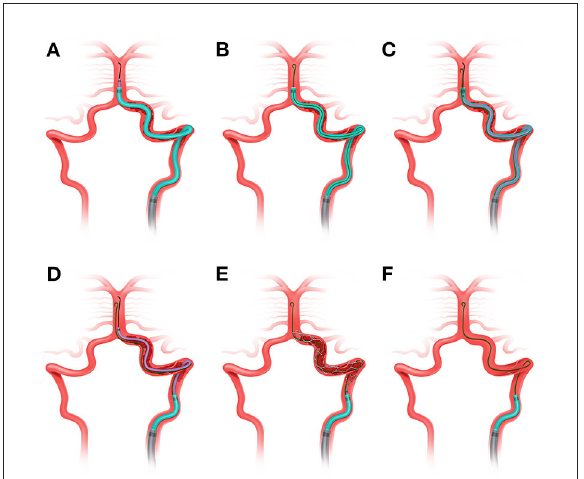
FIGURE1 Illustration of “standby microwire technique”. (A) The guiding catheter (gray) was advanced to V1 segment, the aspiration catheter (light green) and microcatheter (purple) were advanced to the basilar artery with the assistance of Synchro microwire (black). (B) A Floppy 300 microwire (dark green) was then exchanged with Synchro microwire and stayed in the basilar artery. The tip was shaped into protective “J” (black arrow). (C) The microcatheter was then advanced through the dissection to the basilar artery. (D) The aspiration catheter was retrieved to proximal part of dissection under continuous aspiration. (E) Synchro microwire was withdrawn and the self-expandable stent retriever was advanced to the distal part of dissection and was then delivered. (F) The thrombus was removed with the stent through the aspiration catheter, without affecting the position of the exchange